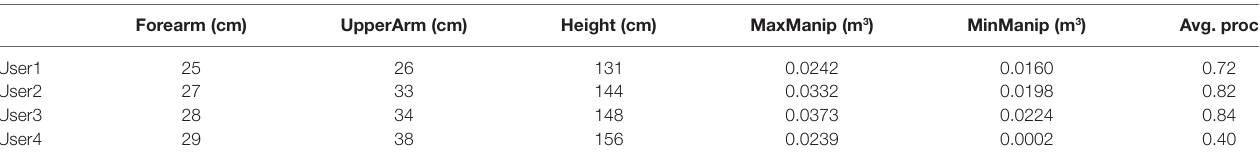
TaBle 4 | Variation of the arm parameters of four selected users, the predicted manipulability and task accuracy.